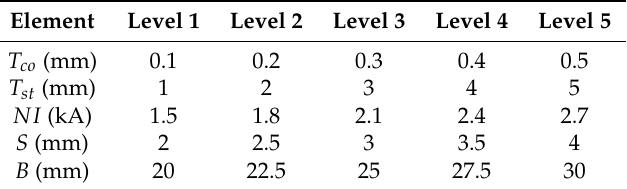
Figure 6. Design parameters to be optimized. Table 1. The parameters of sample space.